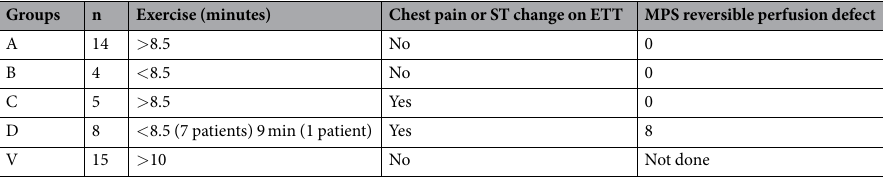
Table 1. Characteristics of subjects studied for changes in depolarisation vectors. Groups A–D refer to patients and Group V to the